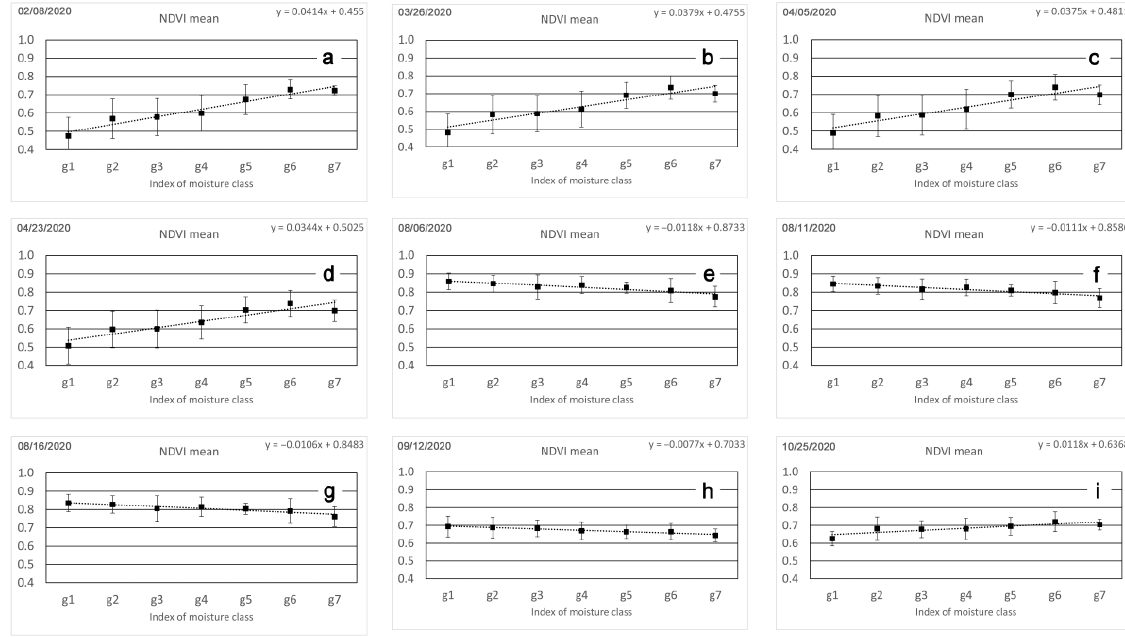
Figure 6. Average NDVI value of the index over year 2020: ( a ) on 8 February; ( b ) on 26 March; ( c ) on 5 April; ( d ) on 23 April; ( e ) on 6 August; ( f ) on 11 August; ( g ) on 16 August; ( h ) on 12 September; ( i ) on 25 October .